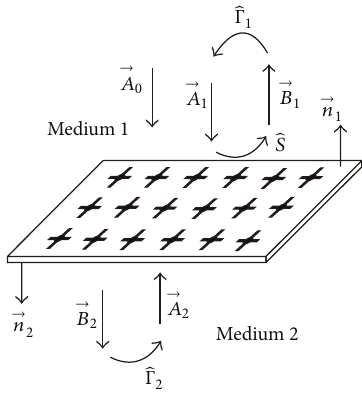
Figure 3: WCIP formulation at the circuit